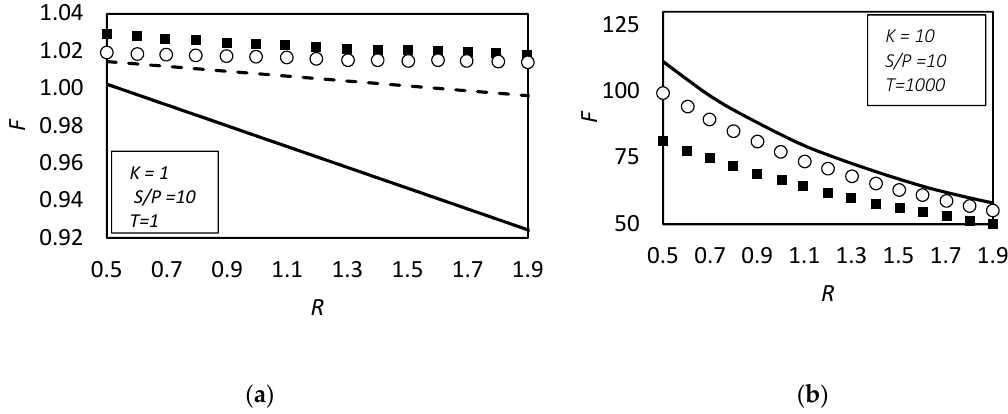
Figure 6. Diffusivity ratio influence on facilitation. ( a ) Small Damköhler number. Black squares and white circles are numerical results for P = 1 and 0.5 respectively, full and broken lines are Equation (120) for P = 1 and 0.5 respectively; ( b ) Large Damköhler number. Black squares and white circles are numerical results for P = 1000 and 10,000 respectively. Full line is Equation (124). In both the case small but nonzero downstream concentration has been considered ( C L = ¯ A = 0.01).